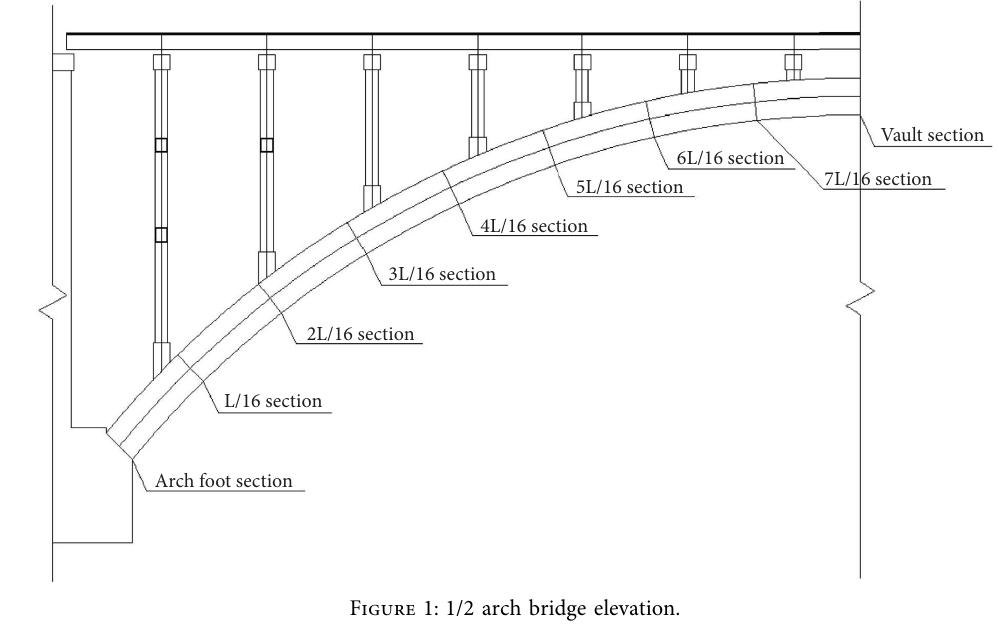
Figure 1: 1/2 arch bridge elevation.